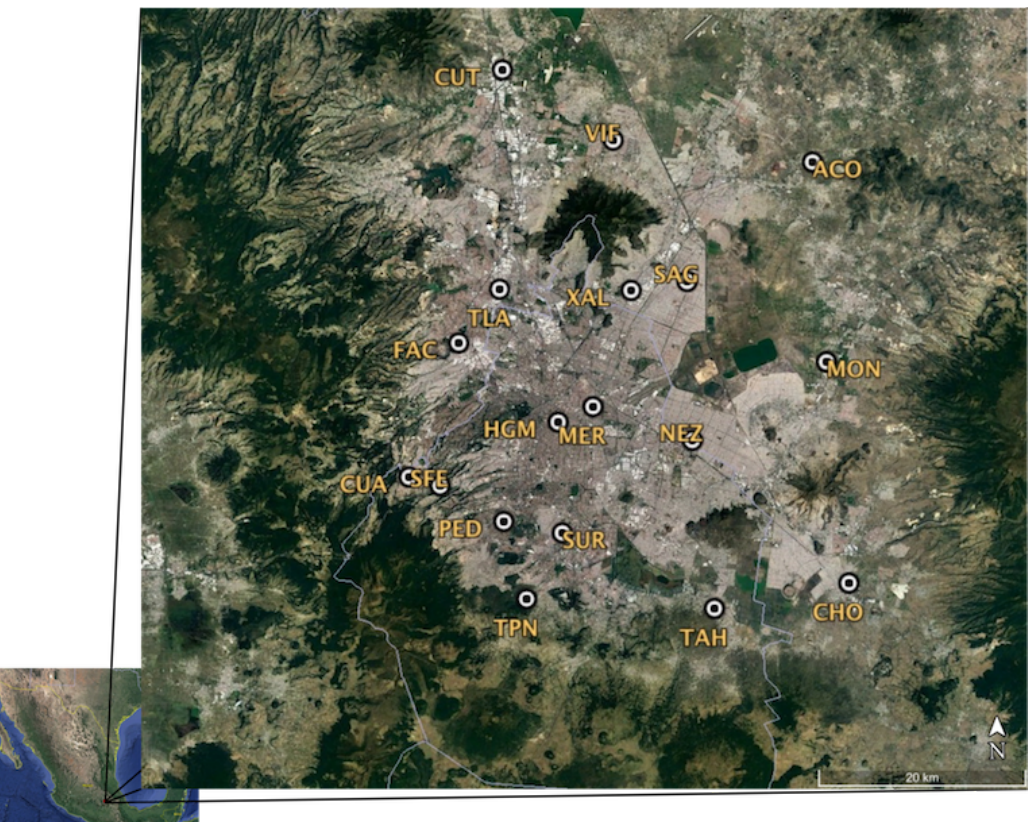
Figure 2. Locations of 18 meteorological stations selected to calculate wind power resource assessments. Names and nomenclature used: Acolman (ACO), Chalco (CHO), Cuajimalpa (CUA), Cuautitlán (CUT), FES-Acatlán (FAC), Hospital General de México (HGM), Merced (MER), Montecillo (MON), Nezahualcóyotl (NEZ), Pedregal (PED), San Agustín (SAG), Santa Fe (SFE), Santa Úrsula (SUR), Tláhuac (TAH), Tlalpan (TPN), Tlalnenpantla (TLA), Villa de las Flores (VIF), and Xalostoc (XAL) (extracted from Automatic Network of Atmospheric Monitoring ( ANAM ) data).